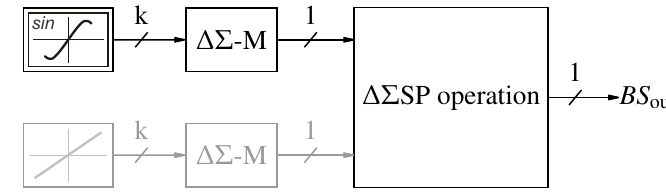
Figure 30. Test bench for non linear functions with optional second input in